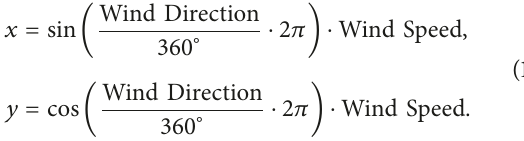
datasets (one for each monitoring point) are composed out of 2,223 instances. Each data point consists of 4 parameters indicating daily values of precipitation accumulation (mm), wind direction (0–360 ∘ ), wind speed (m/s), and observed fine particle concentrations ( 𝜇 g/m 3